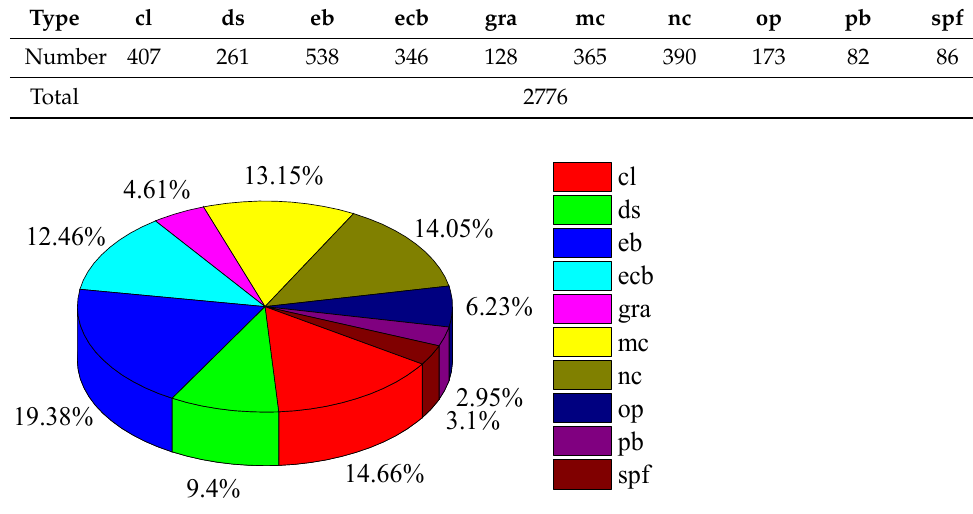
Figure 1. The distribution ratio of each type of defect image.